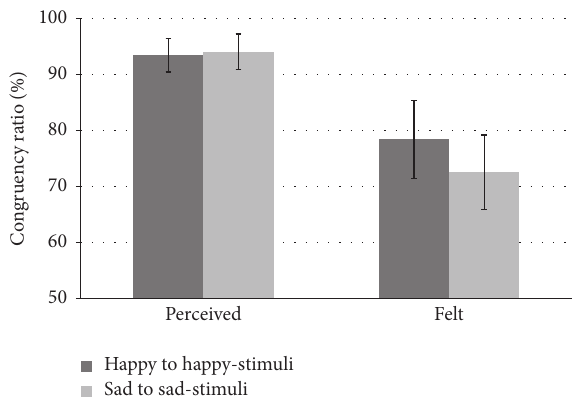
Figure 1: Congruency ratio of selected adjective to music categories. The bars represent standard